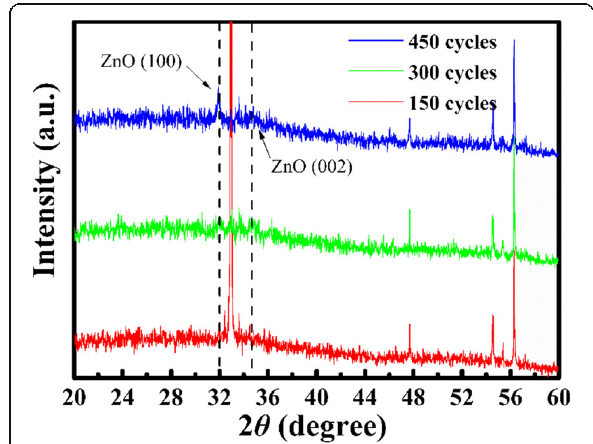
Fig. 3 XRD patterns of the AZO thin films with different thicknesses